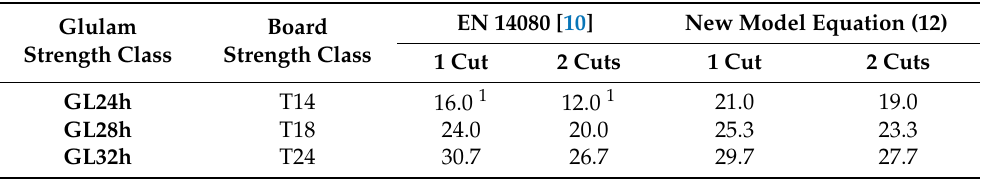
Table 14. Comparison of the characteristic bending strengths in (MPa) of resawn glulam beams according to the current regulations in EN 14080 [10] and the new proposed model in Equation (12)